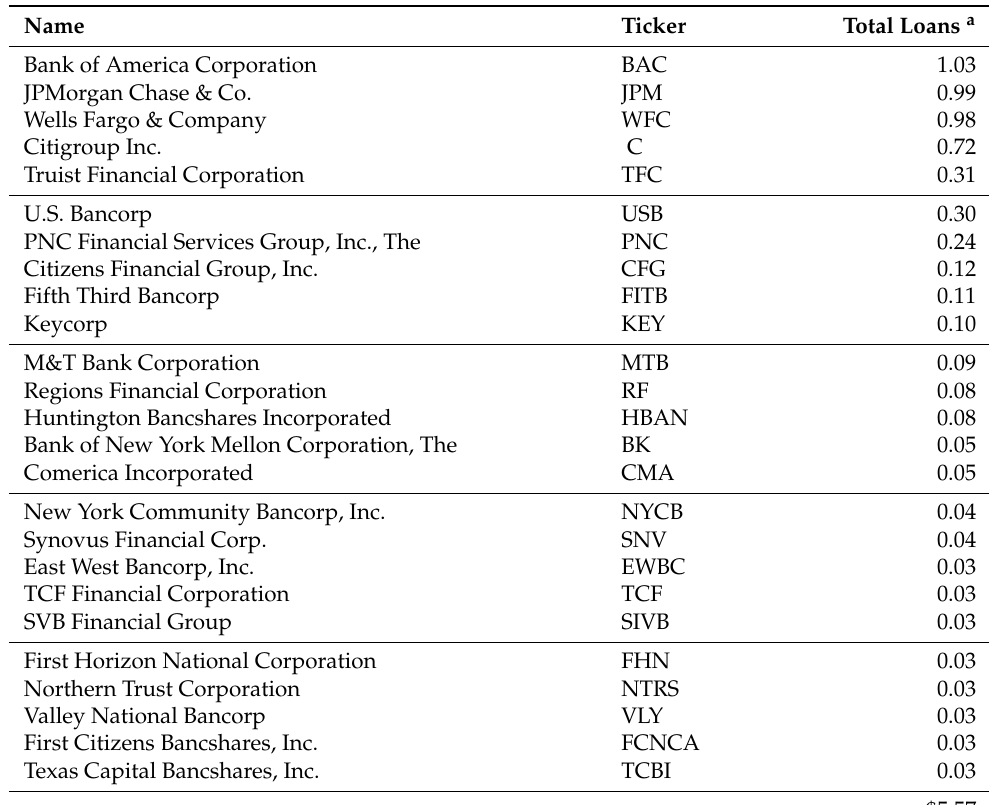
Table 2. U.S. bank holding company sample ranked by total